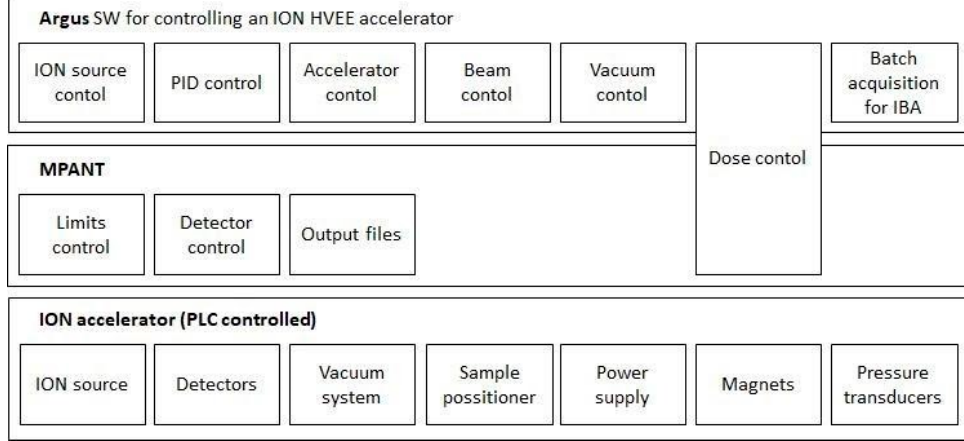
Figure 3. ARGUS and MPANT software and a control overview of the Tandetron technology.